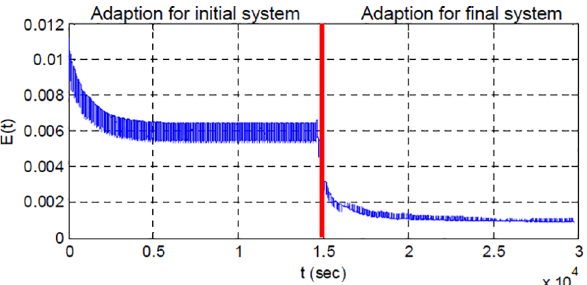
Fig 9. The short-time averagesquare error calculated for the second simulation